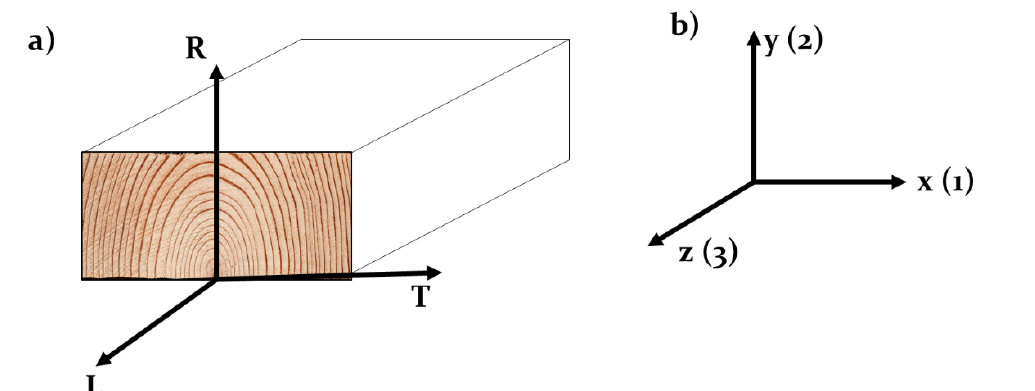
Figure 8. Timber material directions: ( a ) local coordination; ( b ) global coordination.